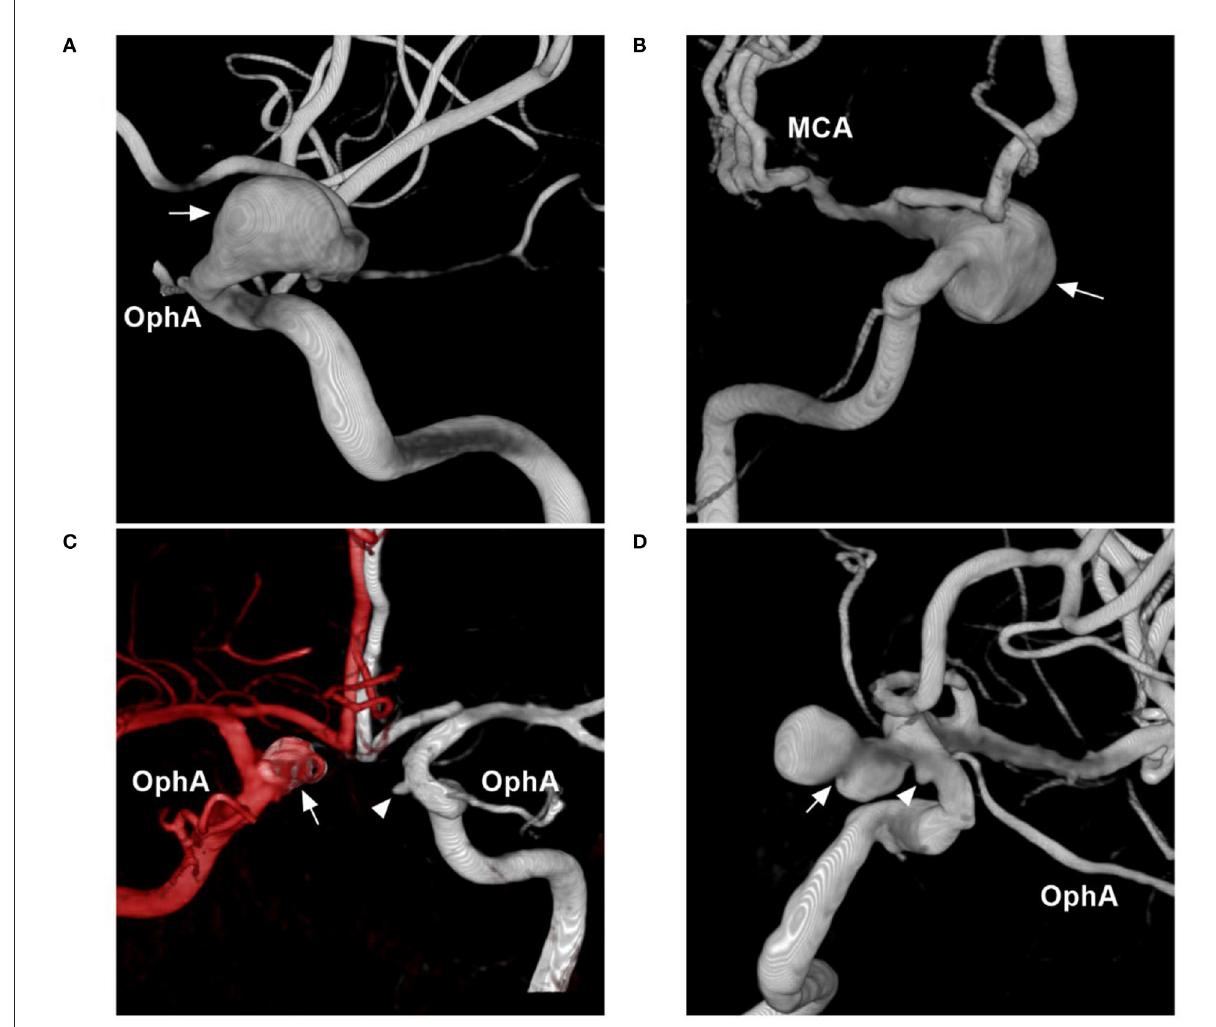
FIGURE4 Other classifications of aneurysms of the paraophthalmic segment. (A) Three-dimensional DSA shows a fusiform aneurysm (arrow) of the paraophthalmic segment, which also belongs to dissection. (B) Three-dimensional DSA shows a large SHA aneurysm (arrow). (C) Three-dimensional DSA shows bilateral aneurysms: one is a coiled SHA aneurysm (arrow) and the other is a carotid cave aneurysm (arrowhead). (D) Three-dimensional DSA shows two tandem aneurysms: the large aneurysm is an SHA aneurysm (arrow), and the small aneurysm is a carotid cave aneurysm (arrowhead). DSA, Digital subtraction angiography; MCA, middle cerebral artery; OphA, ophthalmic artery; SHA, superior hypophyseal